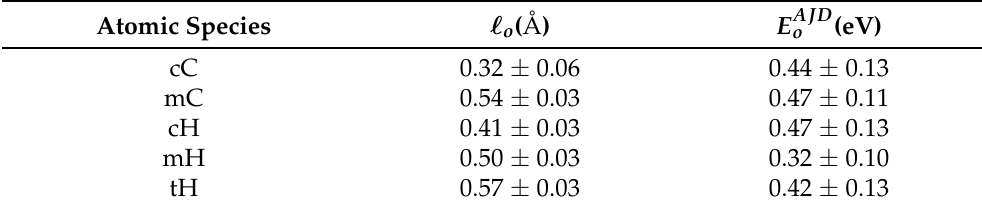
Table 1. Values of the preferred jump length (cid:96) o and activation energy of the characteristic time τ o , E AJD o , involved in the description by anomalous jump diffusion model, for the different atomic species distinguished in